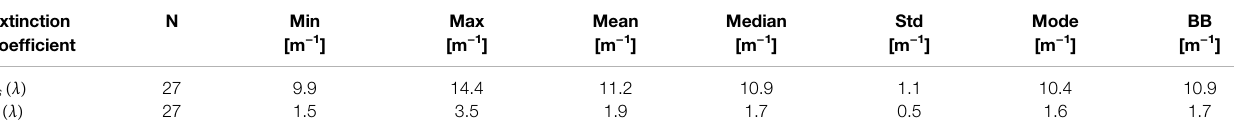
TABLE 3 | Statistics on the spectral snow k s ( λ ) and sea ice k i ( λ ) extinction coef fi cients as inversely retrieved using a two-layer RT model. The trans fl ectance, snow depth, and ice thickness used for the retrieval were measured at the marker locations on 22, 23, and 24 May, respectively. N is the number of measurements used and BB are the broadband values.